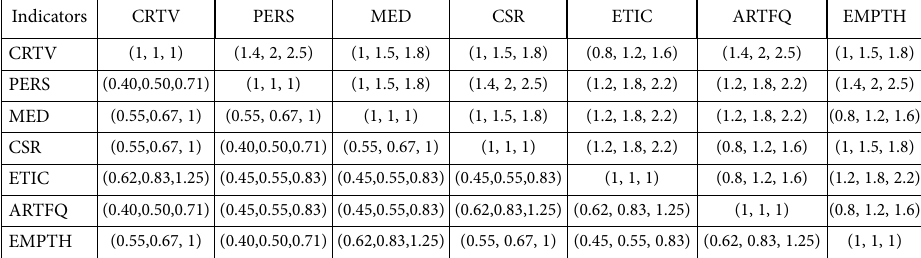
Table 4. Fuzzy pair-wise comparison matrix for the sub-criteria of the non-FP main-criteria